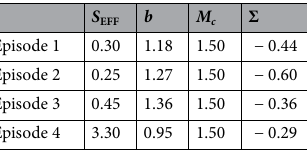
Table 1. Parameters for sensitivity analysis, calibrated using data from episodes 1–4 of project area